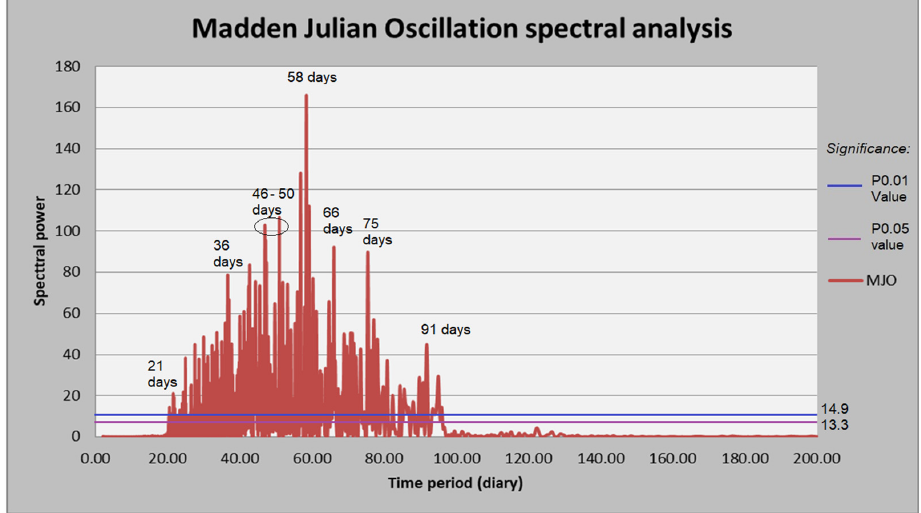
Figure 8. Spectral analysis of the Madden Julian Oscillation for the period 1979–2021 on a daily scale. Red line represents spectral power, P 0.01 (blue line) in 14.9 and P0.05 (purple line) in 13.3. It is possible to assume that there would be detected cycles every 21 days, 36 days, between 46 and 50 days (1 month and a half), 58 days (1 month and 3 weeks), 66 days (2